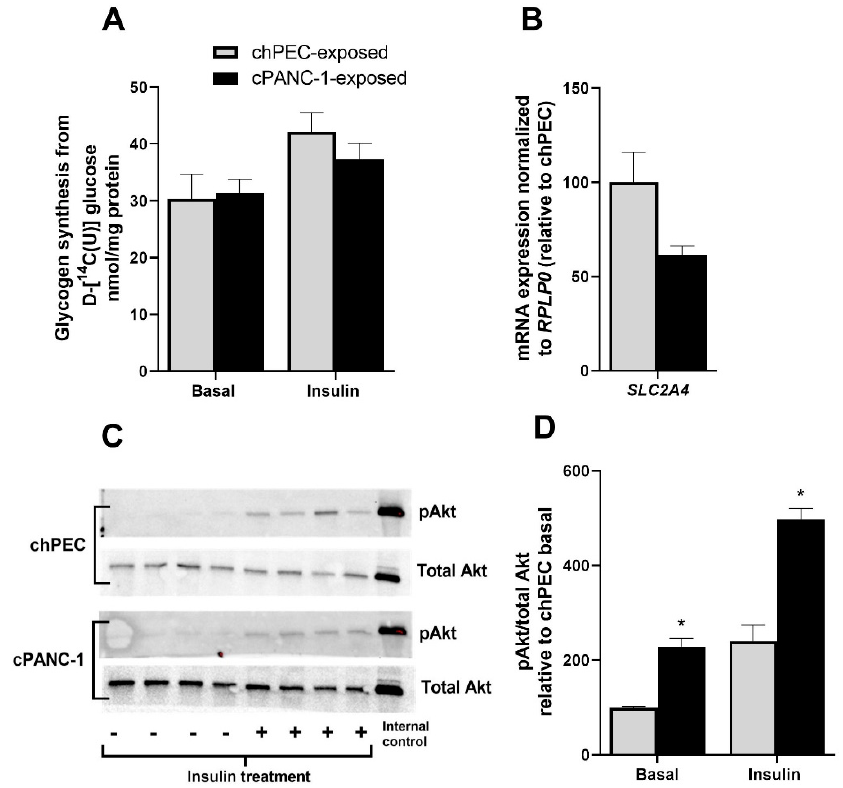
Figure 4. Impact of conditioning myotubes with medium from hPECs or PANC − 1 cells on insulin responses. Myotubes were conditioned with the medium from human pancreatic epithelial cells (chPEC exposed) or a human pancreatic cancer cell line (cPANC-1 exposed) during the last 4 days of the differentiation period. ( A ) After starving myotubes for 90 min in a medium containing no glucose, insulin-stimulated glycogen synthesis was measured as the incorporation of D-[ 14 C(U)]glucose (18.5 kBq/mL, 0.67 mmol/L) into glycogen in the presence or absence of 100 nmol/L of insulin for 3 h. ( B ) mRNA expression of solute carrier family 2 member 4 ( SLC2A4 ) was normalized for the housekeeping gene ribosomal protein lateral stalk subunit P0 ( RPLP0 ), and the expression in cPANC-1-exposed myotubes is presented relative to chPEC-exposed cells ( n = 3–6). ( C ) Immunoblot showing Akt phosphorylated at serine 473 (pAkt) and total Akt and in cells treated with or without 100 nmol/L of insulin for 15 min. ( D ) Quantified immunoblot showing the pAkt/total Akt ratio, adjusted to the internal control (HEK cells) and presented as a percentage of basal chPEC ( n = 4). Data in ( A , B , D ) are presented as the mean ± SEM. * Statistically significant in cPANC-1-exposed myotubes versus chPEC-exposed myotubes ( p ≤ 0.05, unpaired t -test).